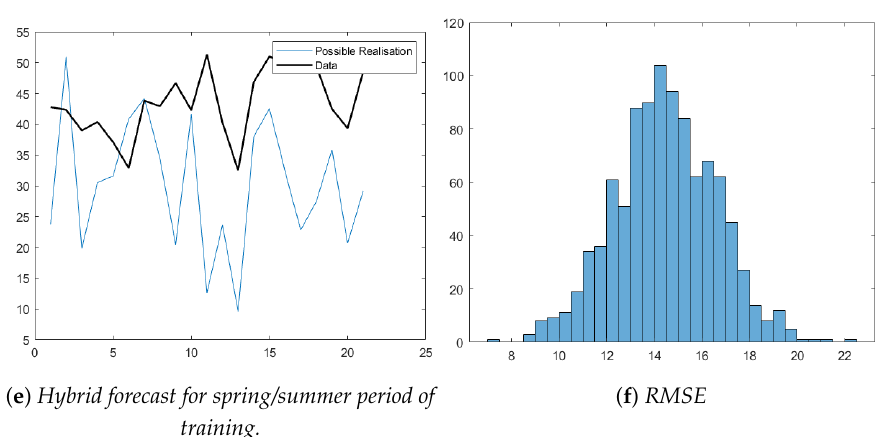
Figure 21. Summary of results of probabilistic hybrid approach for each time period of training for a time horizon of three